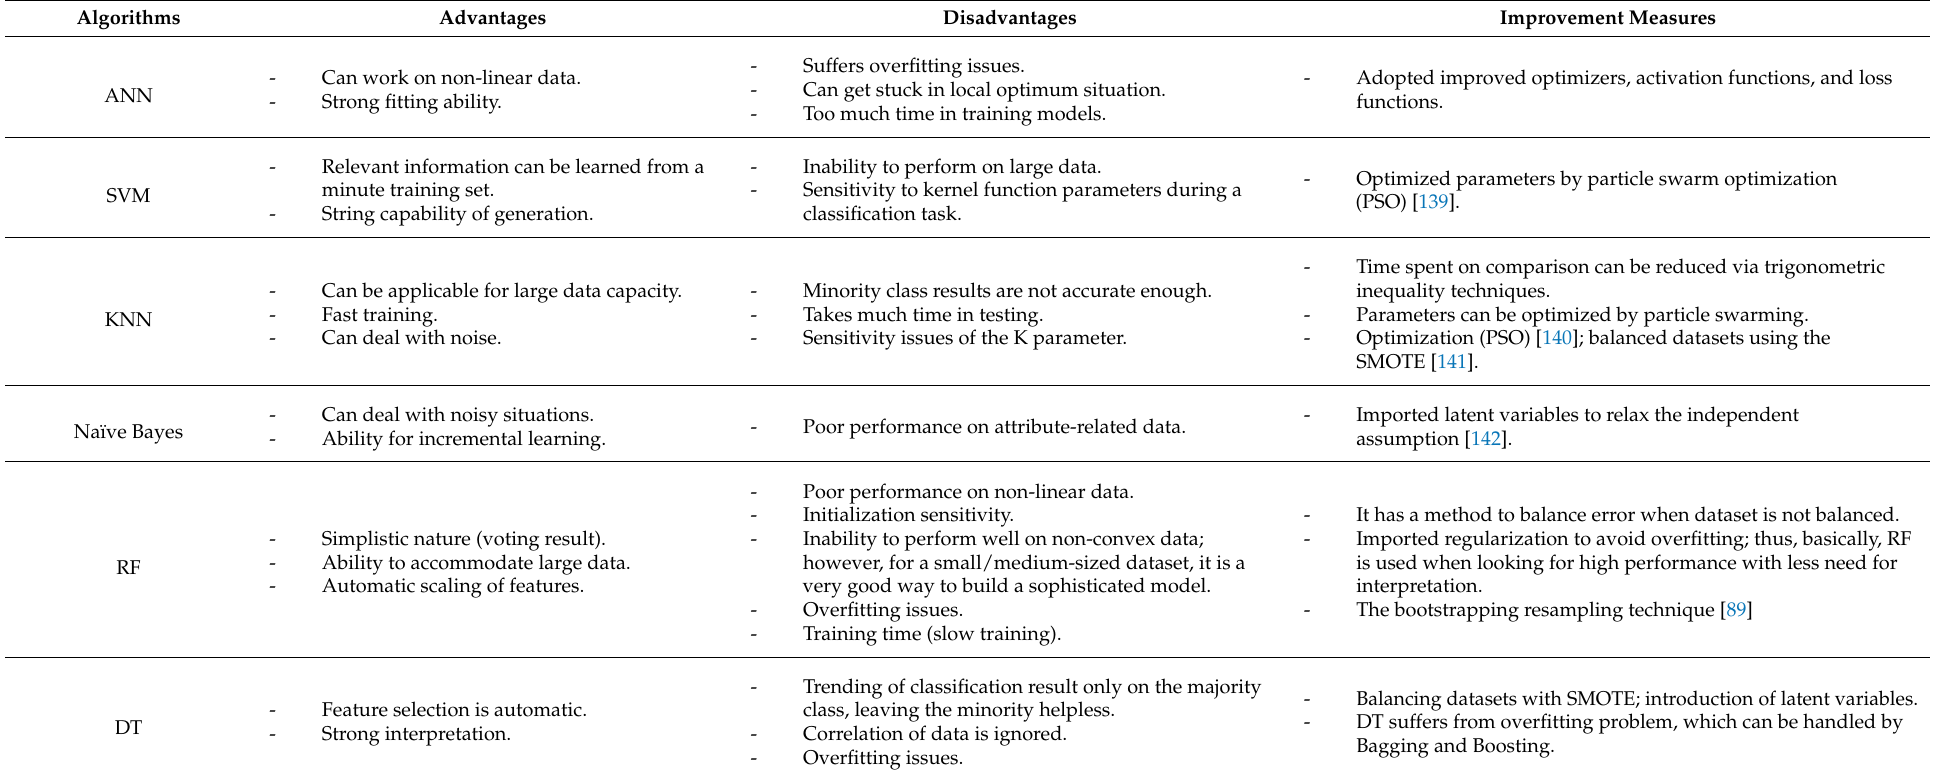
Table 6. The pros and cons of various shallow